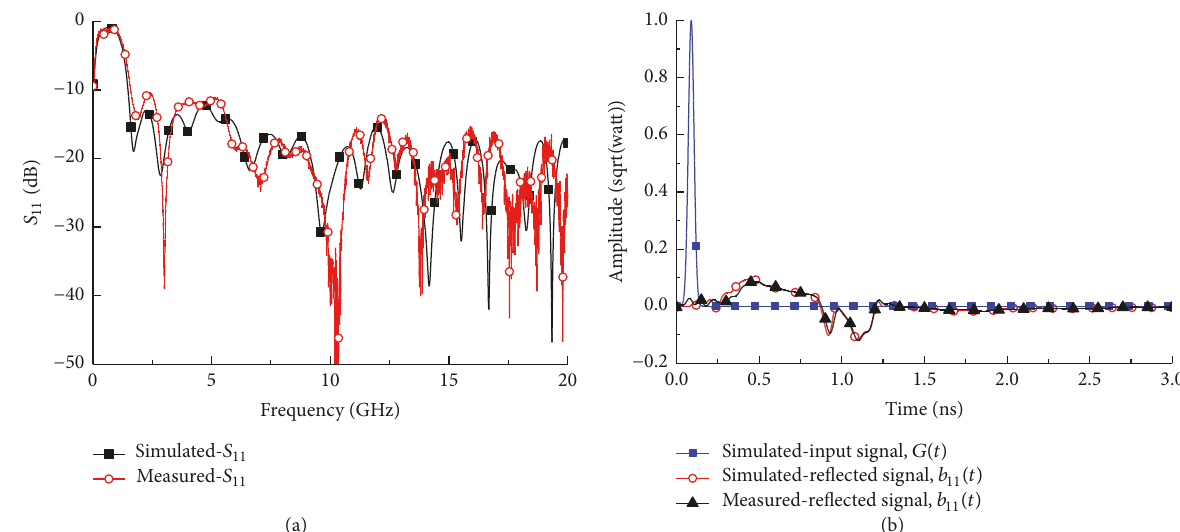
Figure 4: Simulated and measured port parameters. (a) Simulated and measured reflection coefficients and (b) input and reflected signals.